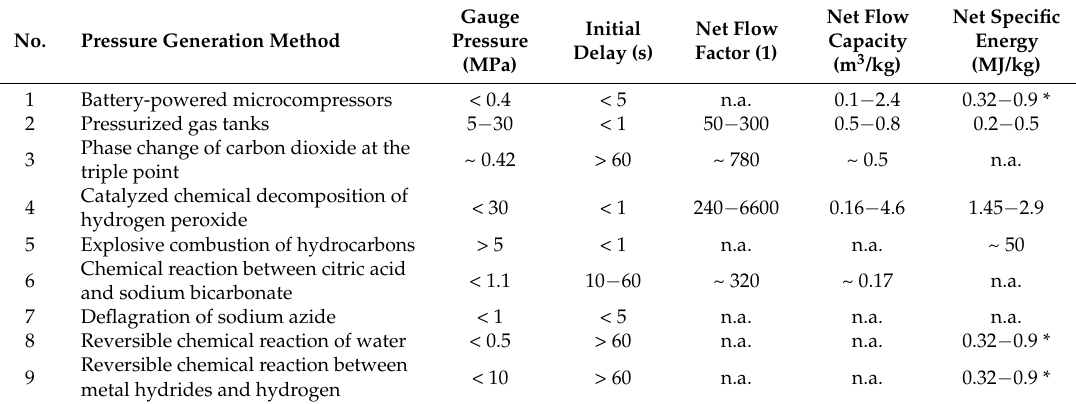
Table 8. Quantitative evaluation and comparison of all presented pressure generation methods.